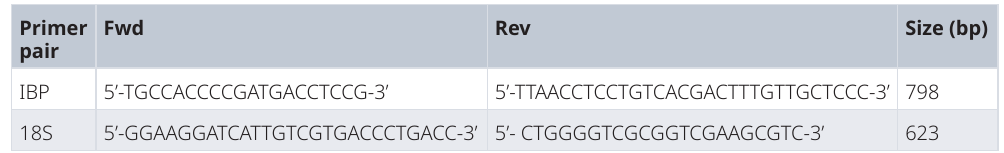
Table 1. Primers used in this